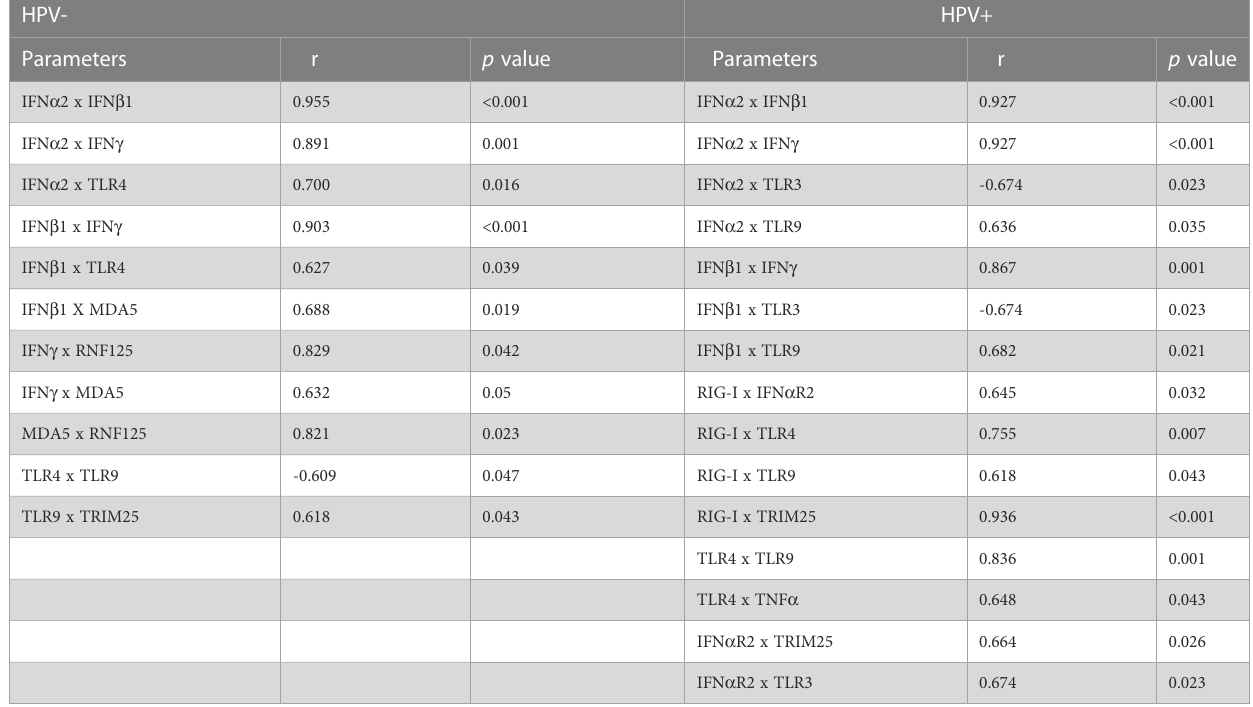
TABLE 2 Correlation analysis of gene expression based on HPV